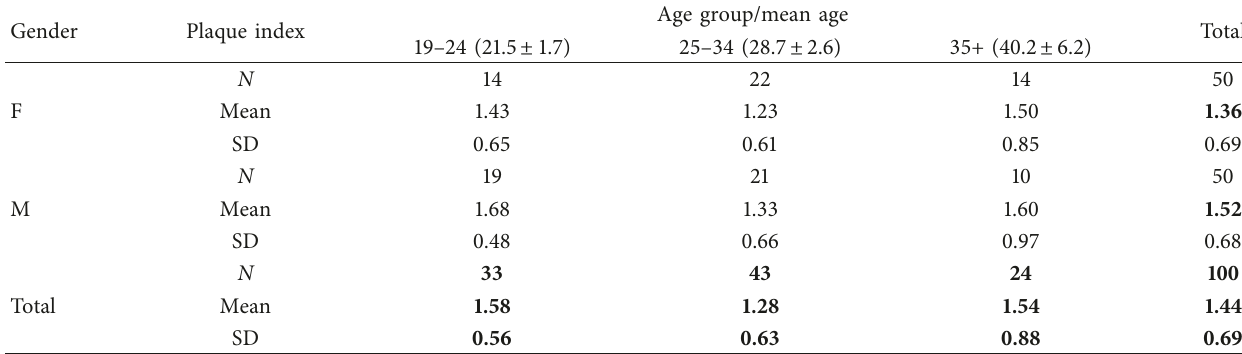
Table 7: Dental plaque index value of adult inmates according to their age group and gender.